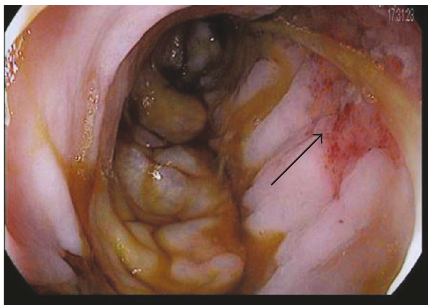
Figure 1: Endoscopic image of the sigmoid colon with areas of mucosal hemorrhage and inflammation.